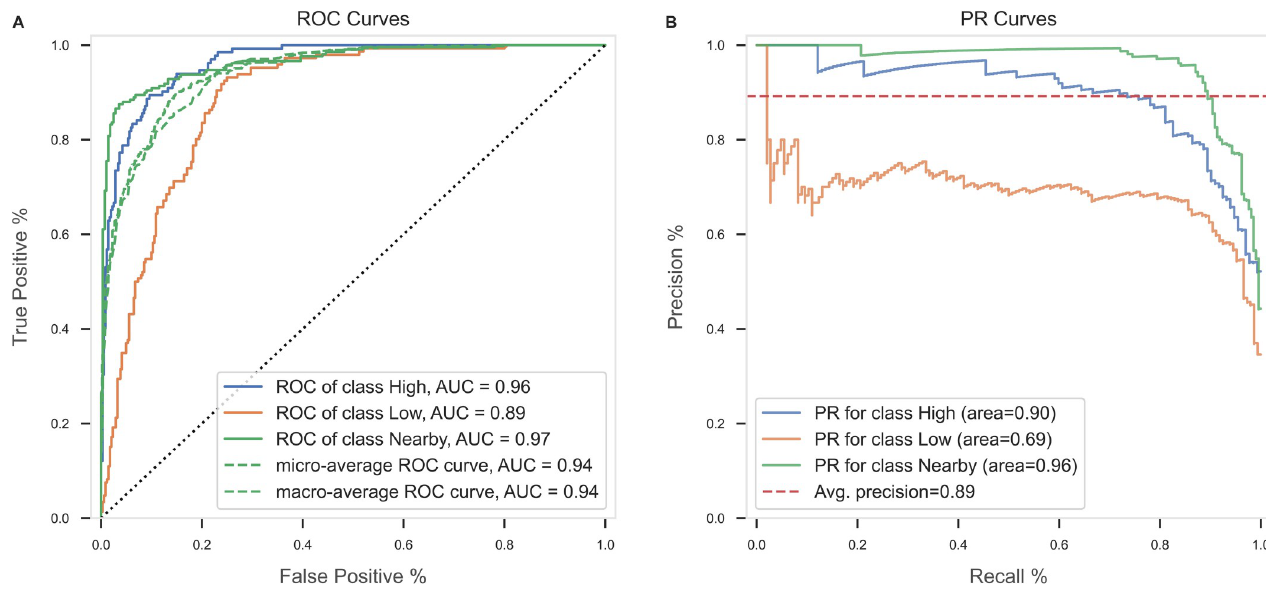
Fig 6. Evaluation of RF model to classify each disposal label expressed by ROC curves (A) , and PR curves (B) .